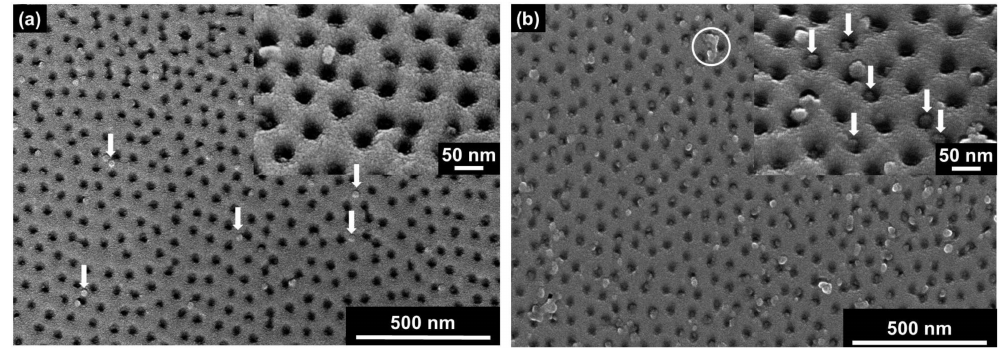
Figure 6. Concentration gradient-driven versus electrophoresis-driven insertion of TMV nanodiscs into SSM pores. ( a ) SEM image of a membrane after the 24-h diffusion experiment; ( b ) the membrane two hours after the electrophoresis experiment using a potential of +100